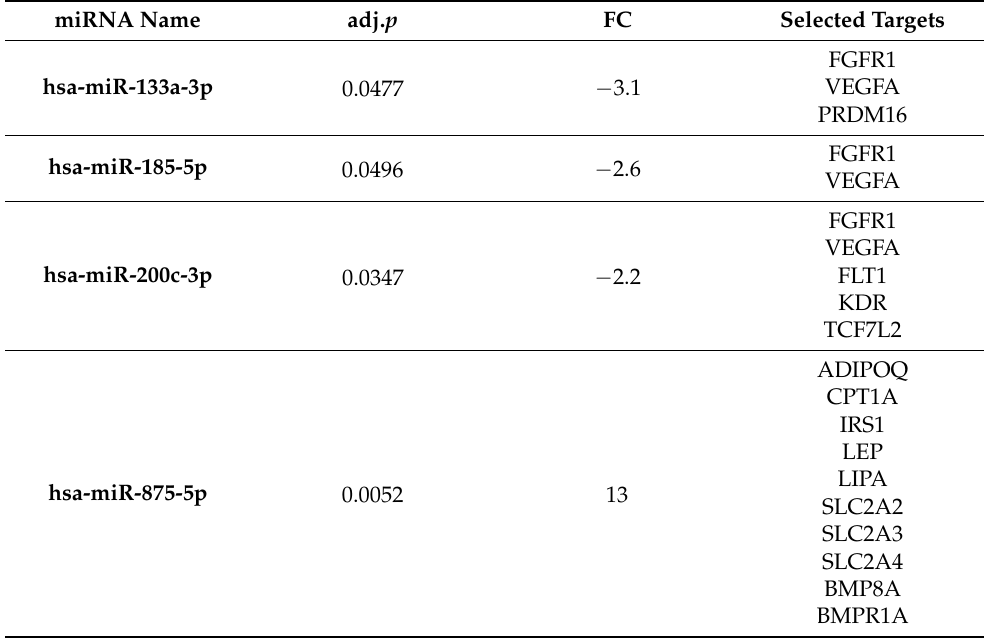
Table 4. Results of the expression of miRNAs by quantitative PCR-TLDA (TaqMan low density array) arrays in leukocytes in the high FGF21 versus low FGF21